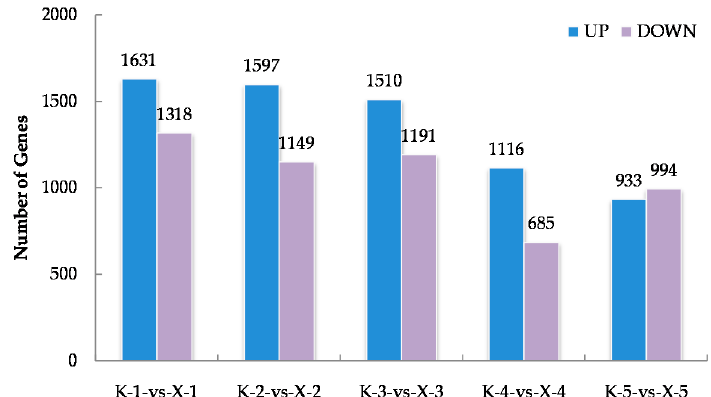
Figure 2. The statistics of up-regulated and down-regulated differentially expressed genes (DEGs) between KN27-3 and XLZ38 during germination under chilling conditions. K-1-vs-X-1, comparison between KN27-3 and XLZ38 at stage 1. K-2-vs-X-2, comparison between KN27-3 and XLZ38 at stage 2; K-3-vs-X-3, comparison between KN27-3 and XLZ38 at stage 3; K-4-vs-X-4, comparison between KN27-3 and XLZ38 at stage 4; K-5-vs-X-5, comparison between KN27-3 and XLZ38 at stage 5. Stages 1-5 represent the sampling hours post imbibition at 12, 18, 30, 42, and 54 h.